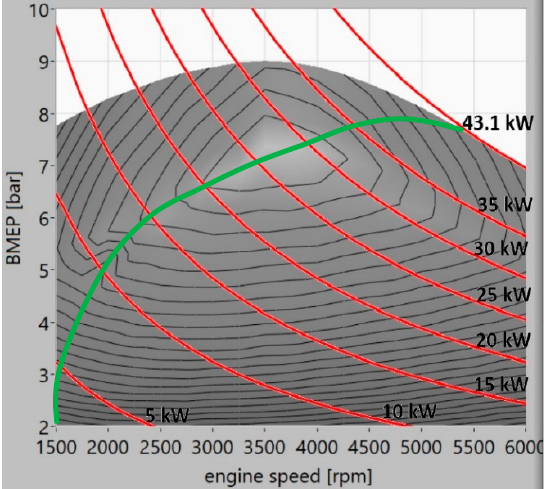
Figure 6. The gasoline ‐ engine BTE map with the BEP in green.